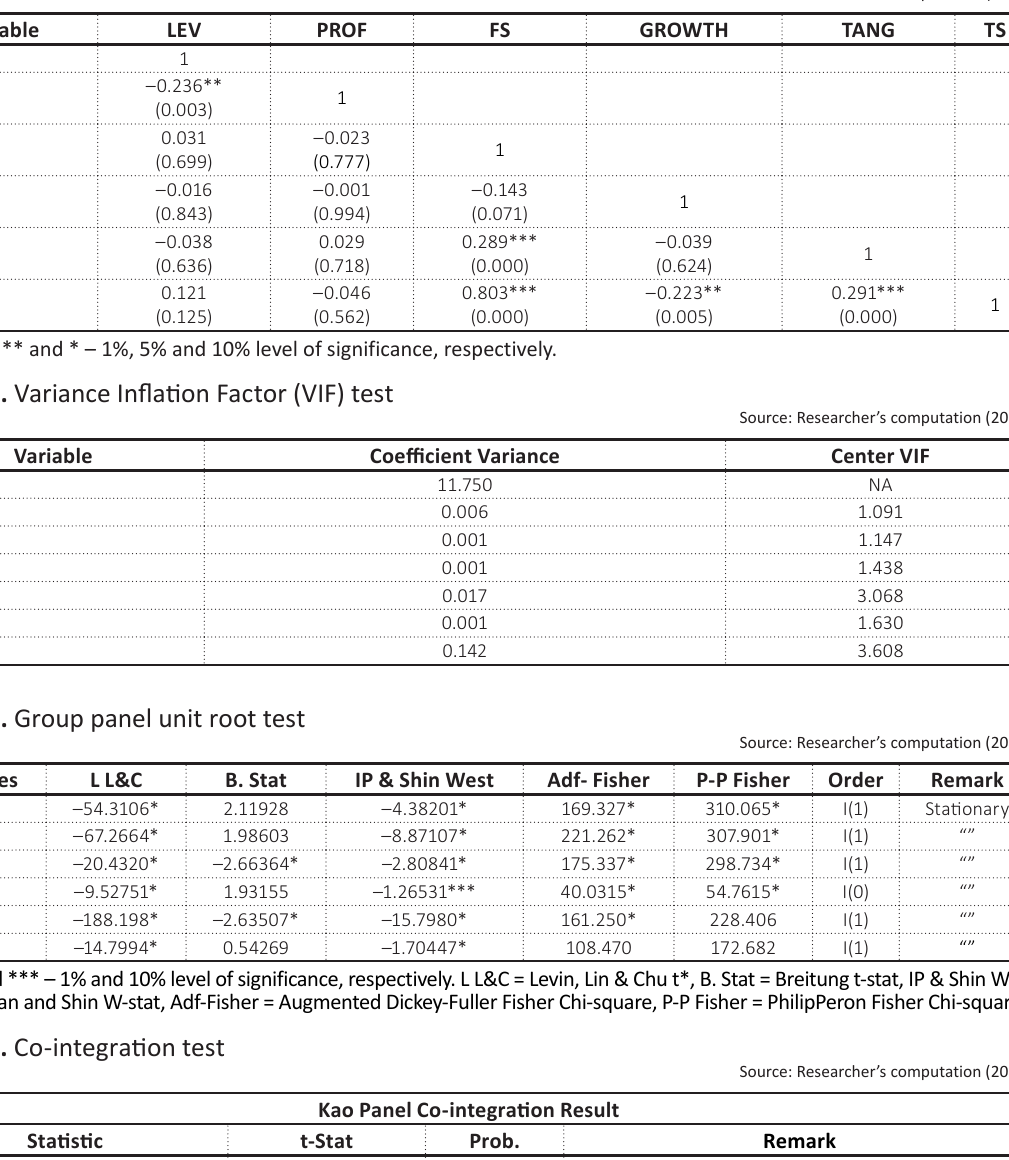
Table A2. Correlation result